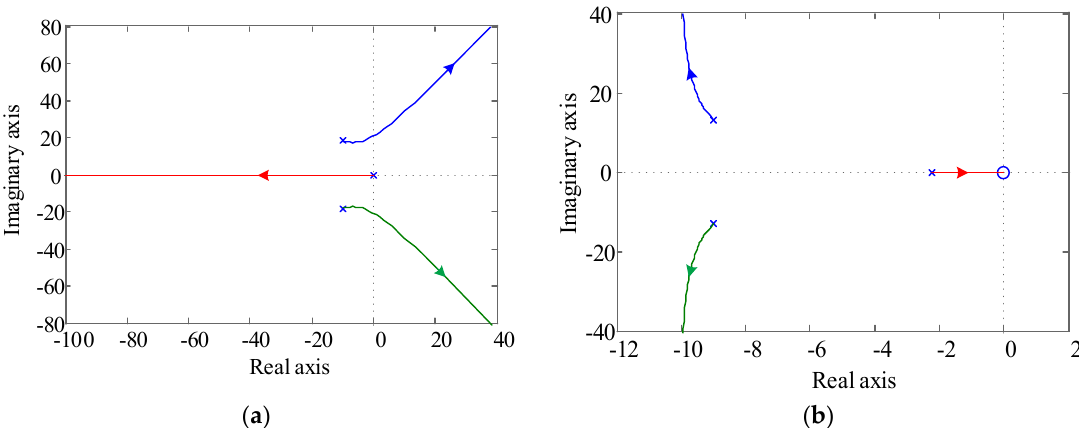
Figure 6. System root trajectory diagram. ( a ) k p / S B1 as the variable ( H vir = 3.5 s); ( b ) k d / S B1 as the variable ( R vir = 0.04).